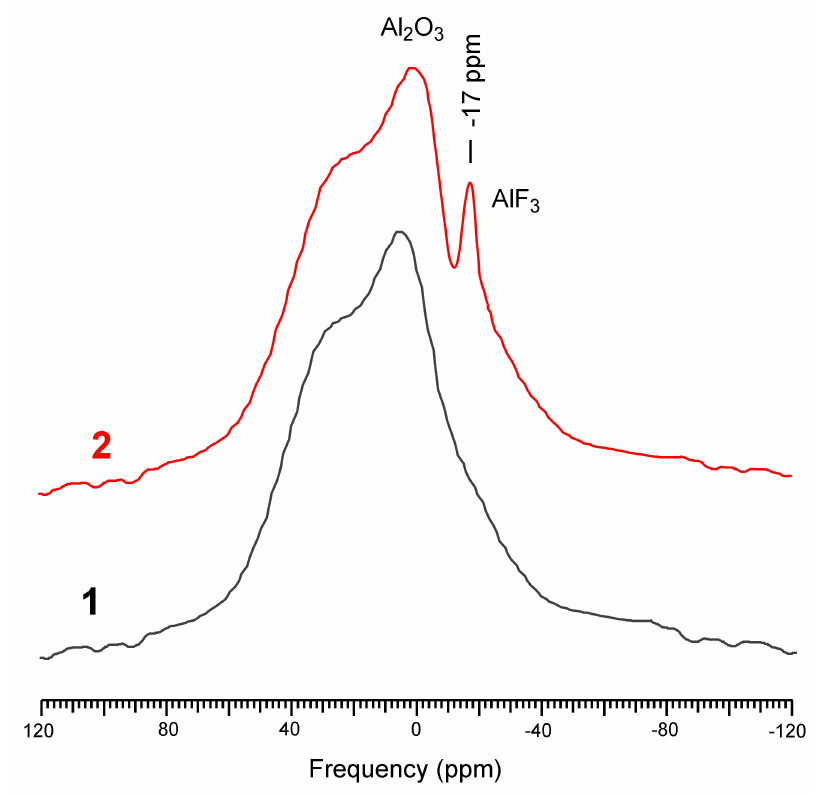
Figure 9. MAS NMR 27 Al sorbent spectra (1) before and (2) after